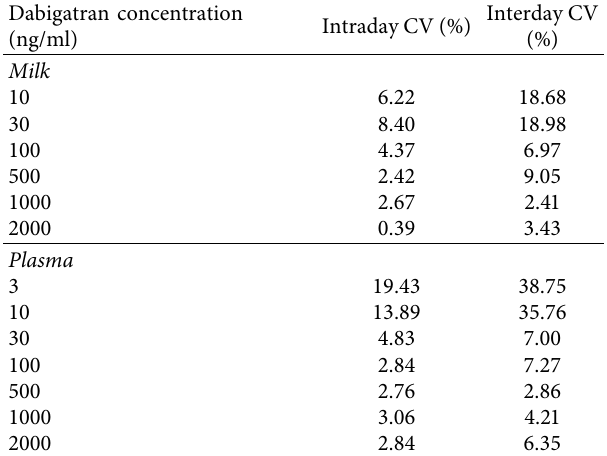
Table 4: Intraday and interday reproducibility. Dabigatran concentration